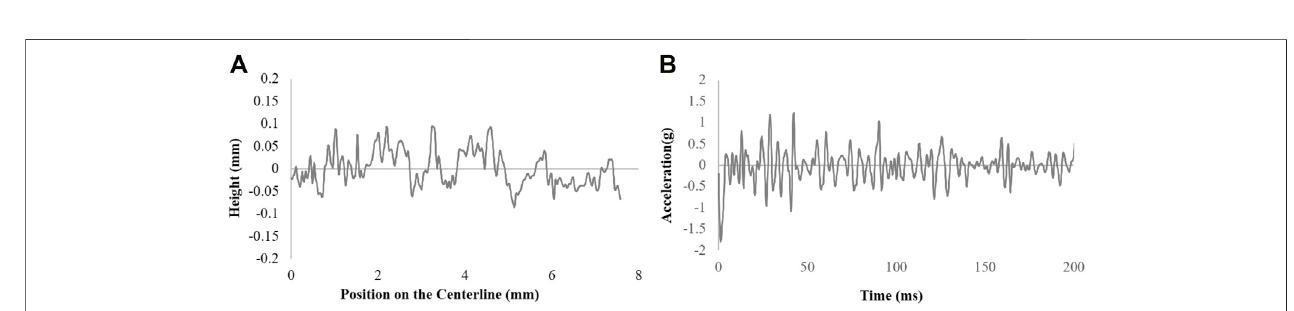
FIGURE 7 | Transformation of displacement to acceleration: (A) original height (displacement) curve; and (B) acceleration transformed from displacement.